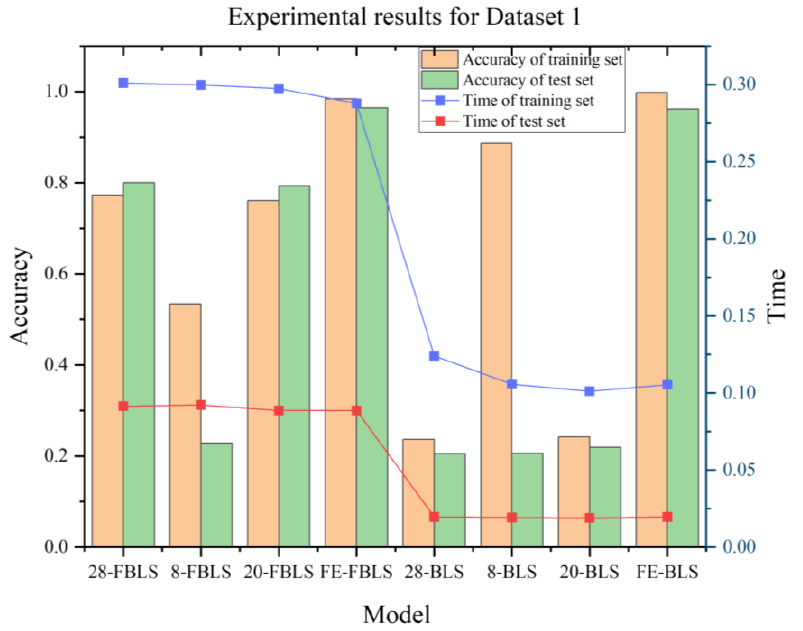
Figure 7. Experimental results of different features on dataset 1.